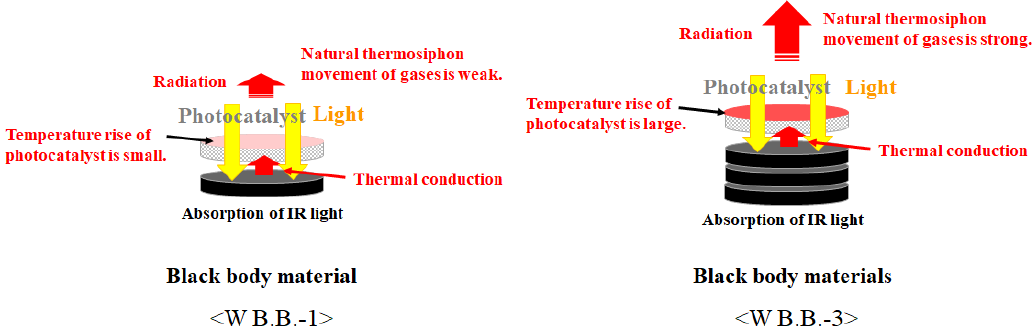
Figure 4. Concept of mass transfer promotion by natural thermosiphon movement of gasses around TiO 2 photocatalyst created by black body material.